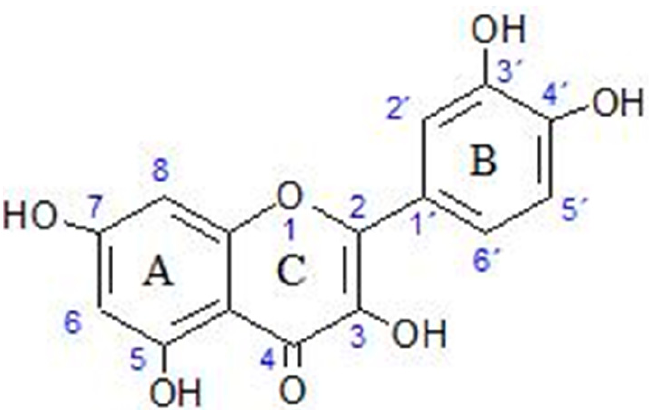
Figure 1. Molecular structure of quercetin.